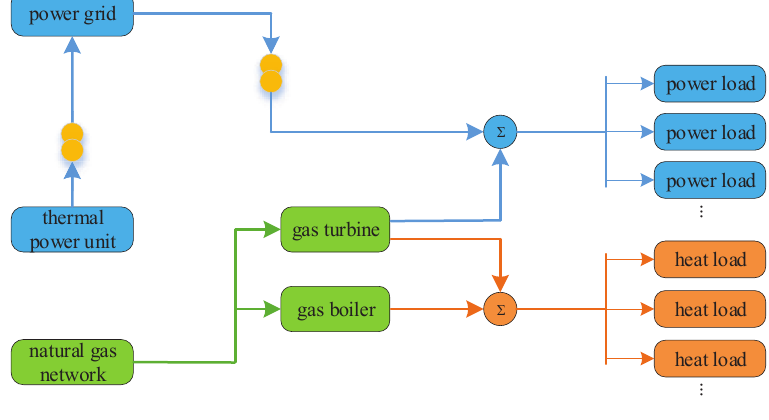
Figure 1. The structure diagram of the IPHS studied in this